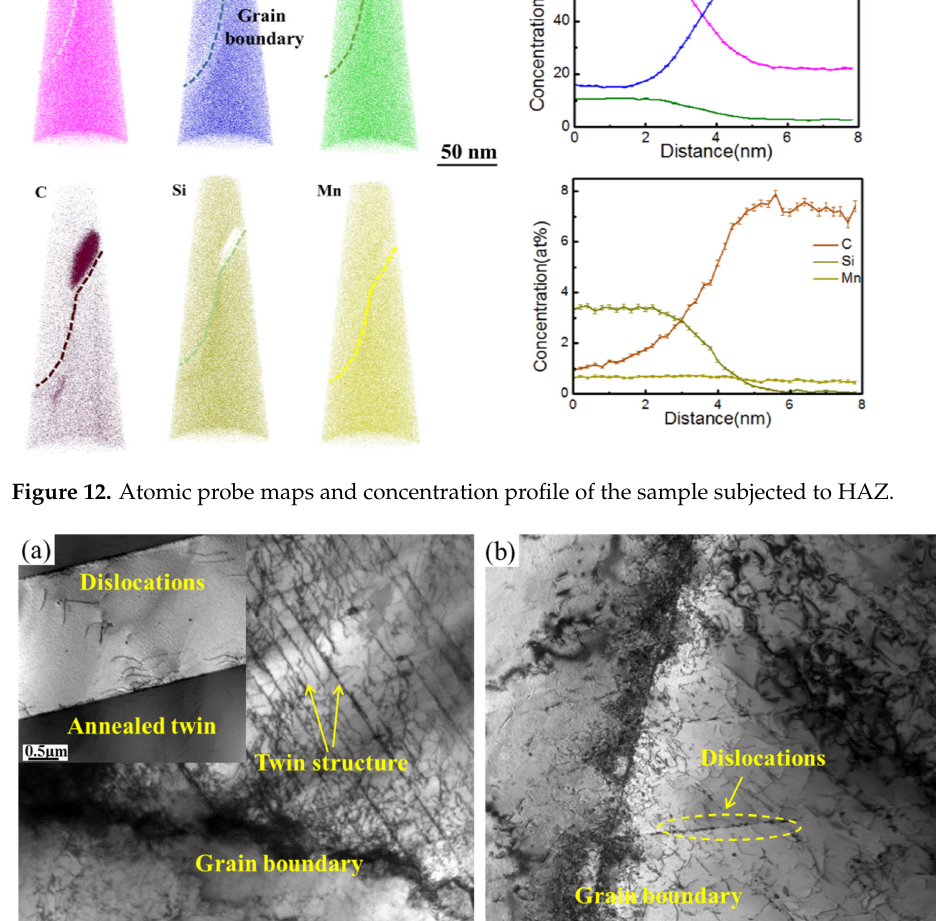
Figure 13. TEM observation of the creep sample in BM: ( a ) twin grain; ( b ) dislocation.